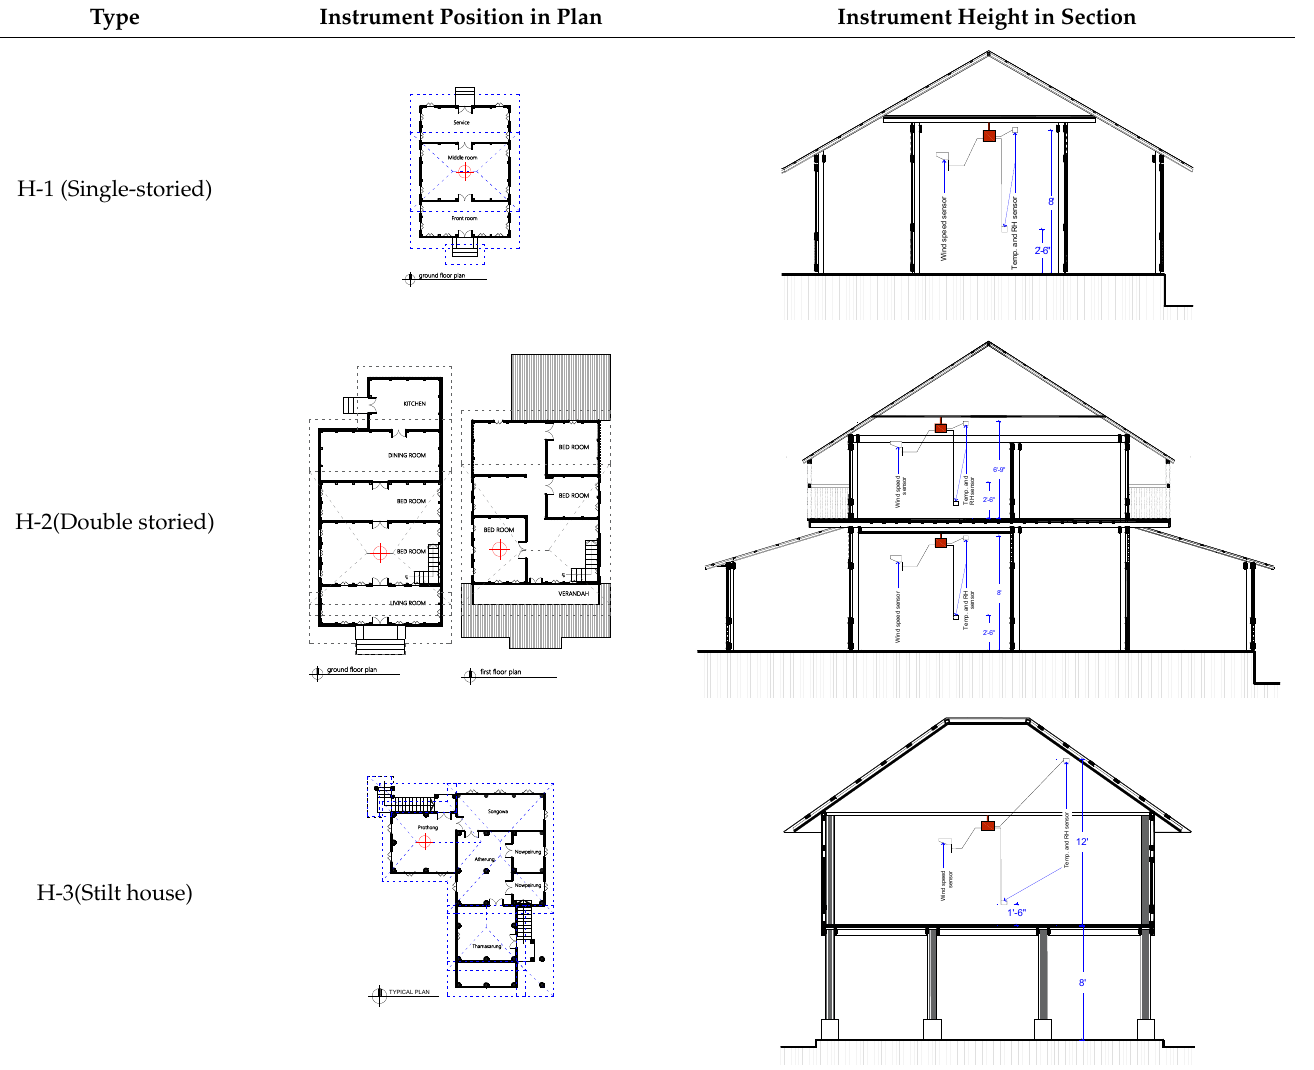
Table 3. Instrument position in plan and section.